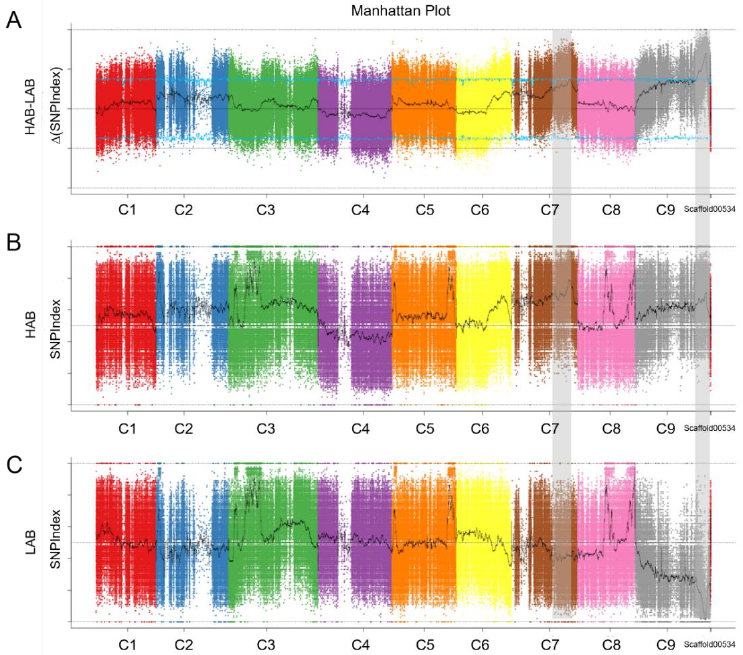
Figure 2. Distribution of two progeny SNP-index on the chromosome length, represented by the horizontal axis (Mb); vertical axis: SNP-index. ( A ) Δ (SNP-index) graphs generated from QTL-seq study; ( B ) SNP-index graphs depicting the HAB (high anthocyanin biosynthesis bulk); ( C ) SNP-index graphs depicting the LAB (low anthocyanin biosynthesis bulk). Gray shaded boxes indicate significant QTLs.